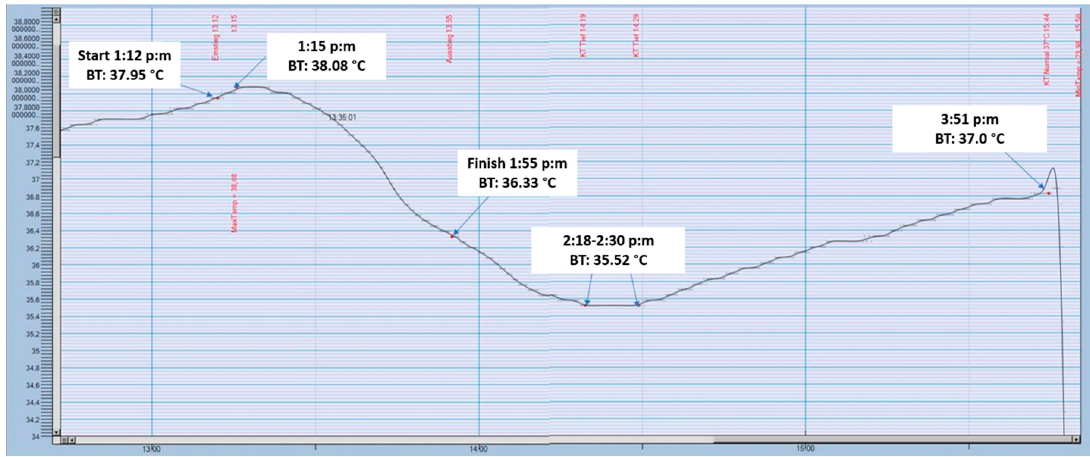
Figure 2. Body core temperature before, during and after an ‘Ice Mile’ (data provided by the athlete with permission). BT: Body temperature.